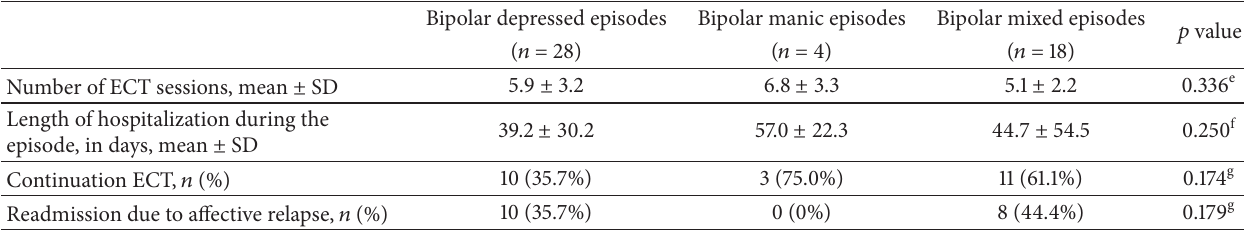
Table 2: Clinical characteristics of the sample of episodes ( 𝑛 = 50 ).